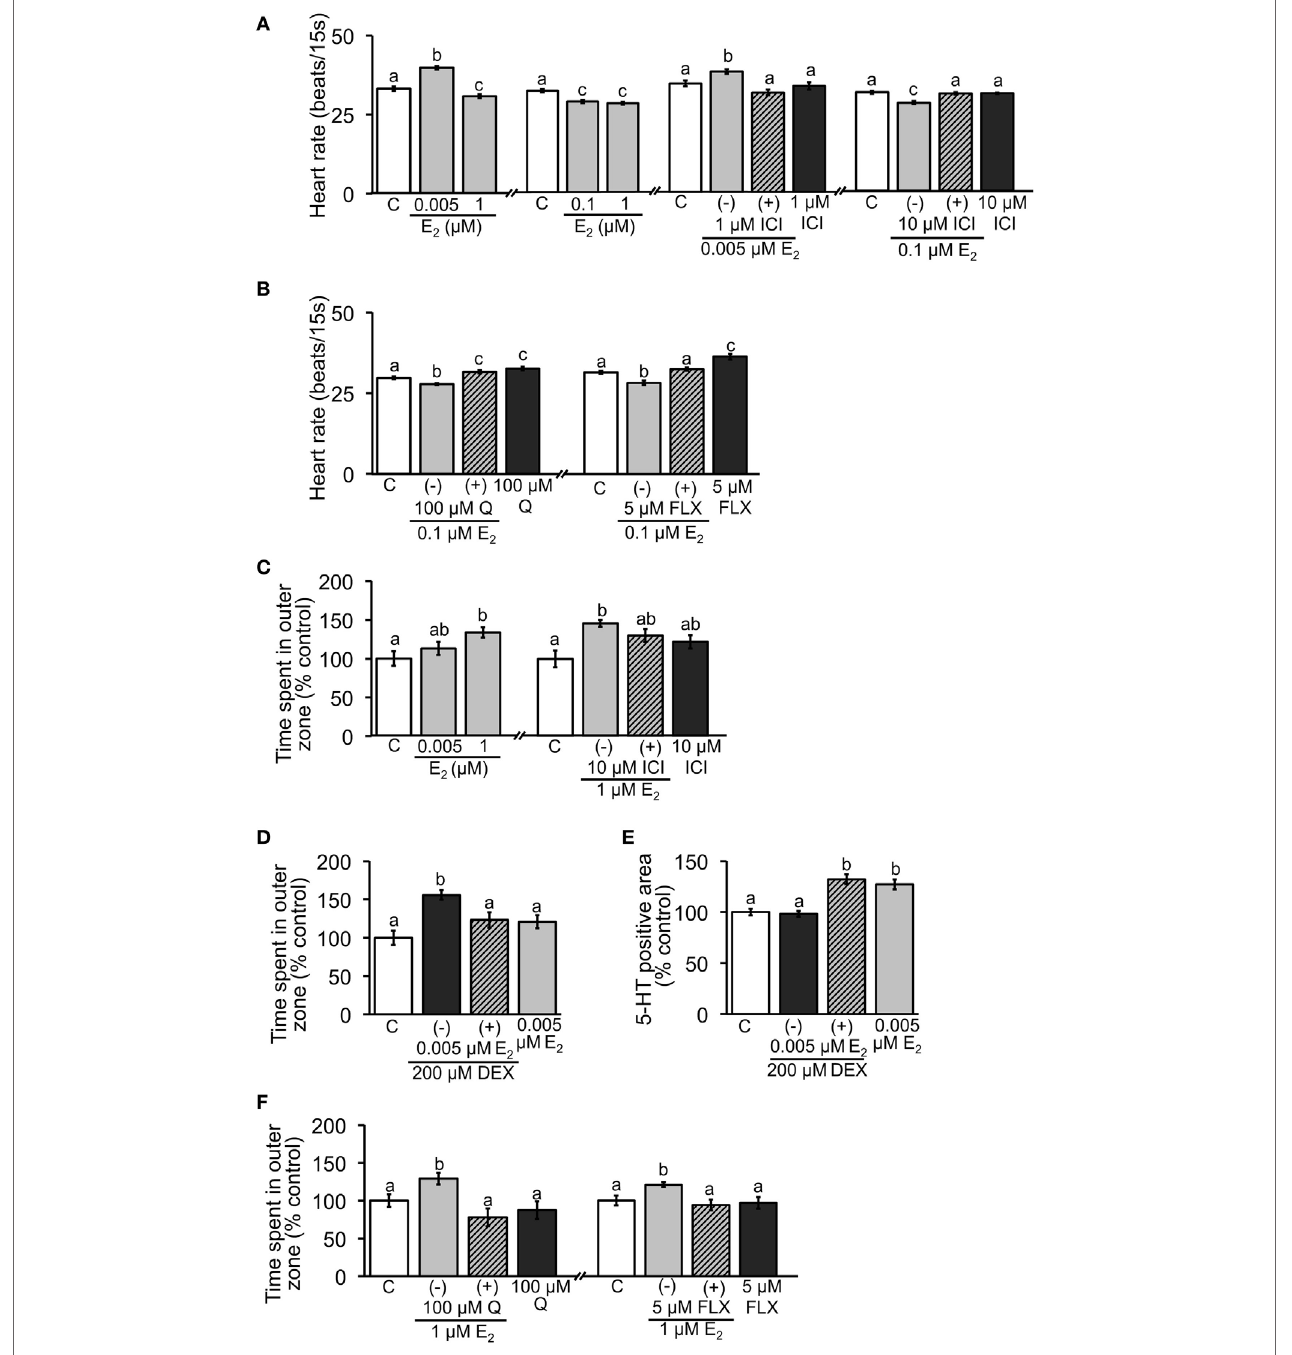
FigUre 2 | Effect of E 2 on heart rate and thigmotaxis. Heart rate was measured in 2-dpf embryos; (a) exposure to low and high doses of E 2 and co-incubation with ICI; (B) co-incubation of E 2 and Q or FLX to examine involvement of serotonin signaling. Thigmotaxis assay was performed to evaluate anxiety level in 6-dpf larvae; (c) exposure to low and high doses of E 2 and co-incubation with ICI; (D) anxiolytic effect of low dose of E 2 when larvae were exposed to 200 µM DEX. (e) Measurements of 5-HT-positive neuron area in 2-dpf embryos exposed to DEX and low dose of E 2 . (F) Effects of co-incubation of E 2 and Q or FLX on thigmotaxis to examine involvement of serotonin signaling. Data are presented as a mean ± SEM. Different letters in each graph indicate significant differences ( p <